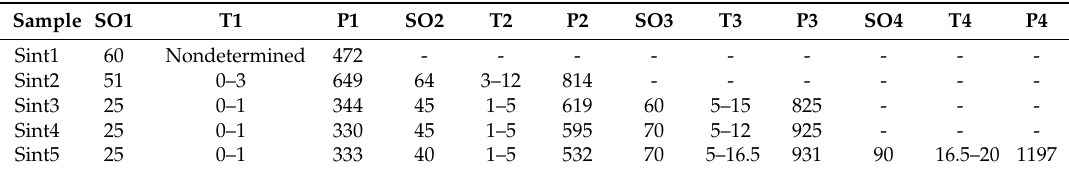
Table 4. Application of the power in each sample (SO, shutter opening (%); T, time (min); P, power